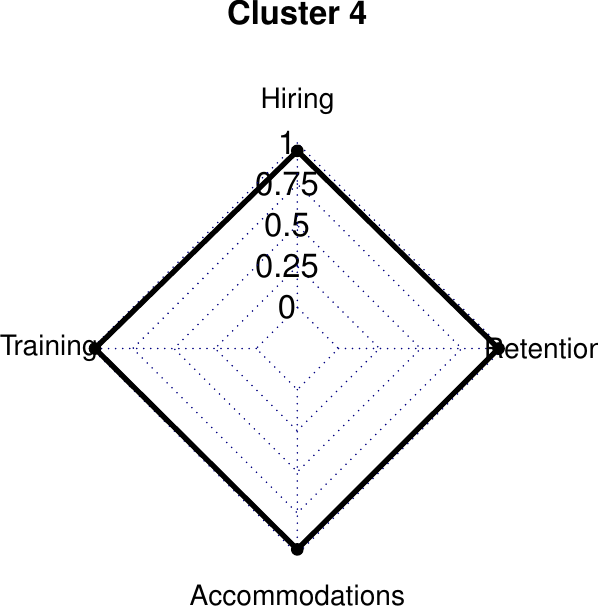
Figure 5. Cluster 4 radar